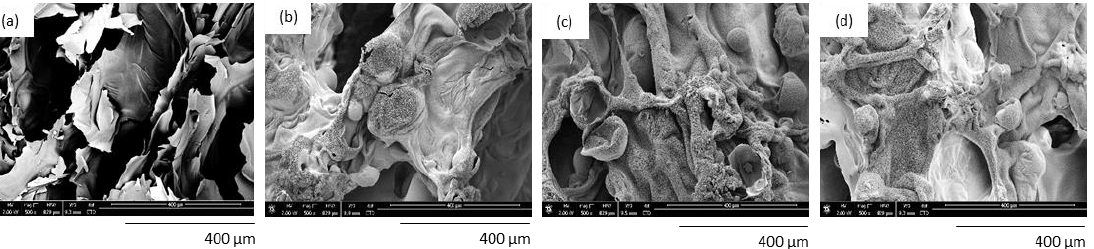
Figure 5. SEM images of char residue of ( a ) PUR_REF, ( b ) PUR_L, ( c ) PUR_L_K, and ( d ) PUR_L_HA (obtained after the cone calorimeter test). Adapted from Ref. [13].